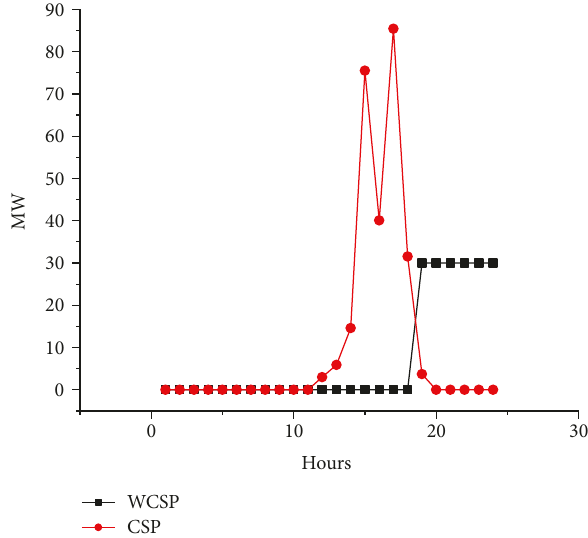
Figure 9: Comparison between the power generation capacity of CSP system and the actual power generation on Equinox